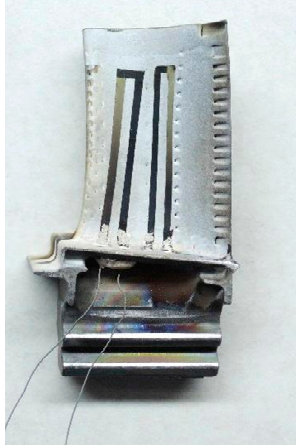
Figure 8. Photo of the turbine blade through-hole lead connection.